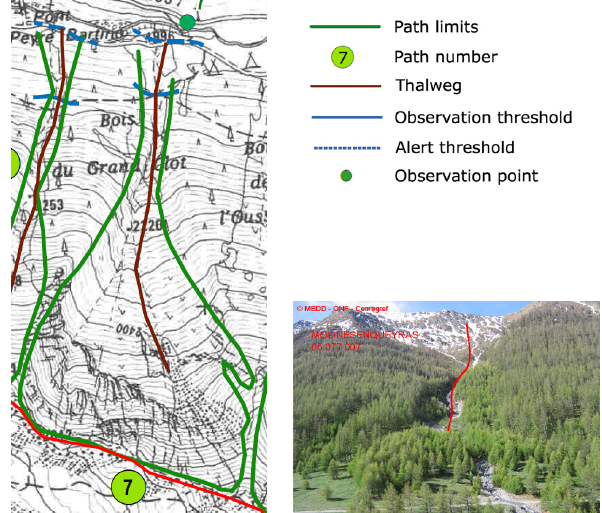
Figure 1. A map and a photograph of the EPA path number 7 in Molines-en-Queyras township. The observation threshold is plotted as a solid blue line. The alert threshold is drawn as a dashed blue line. For this path, the observation threshold is chosen near a large rock block while the alert threshold corresponds to a cross-country ski track. Both thresholds are easily visible and can be identified by an observer from the observation point. The EPA database stores all avalanche events that reached at least the observation